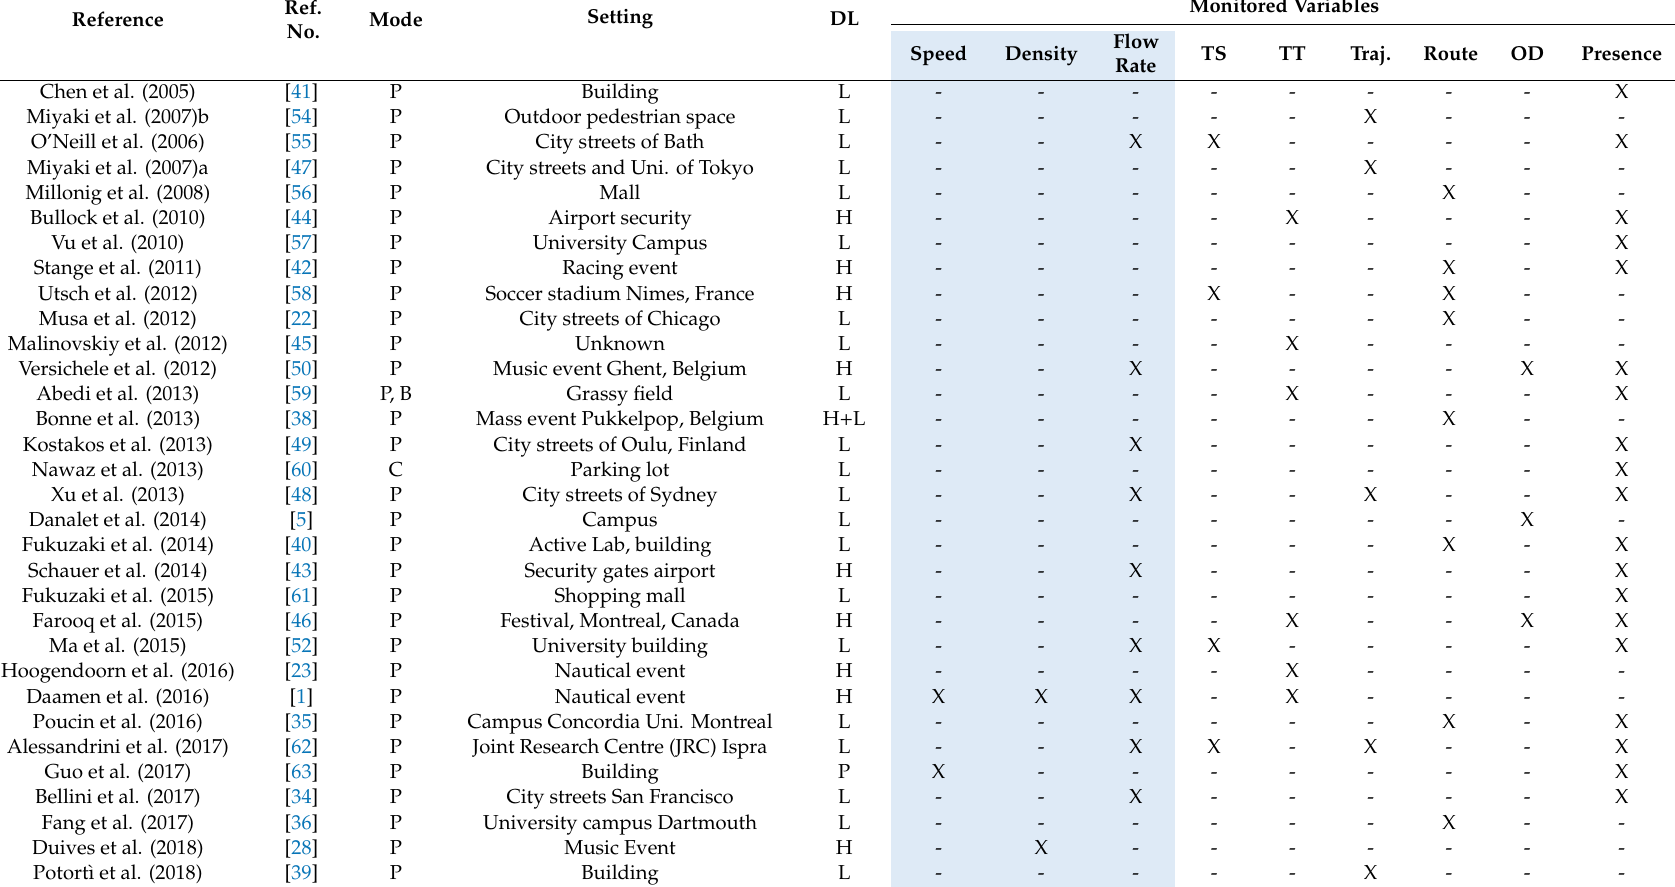
Table 3. Summary of literature related to derivation tra ffi c state using Wi-Fi & Bluetooth